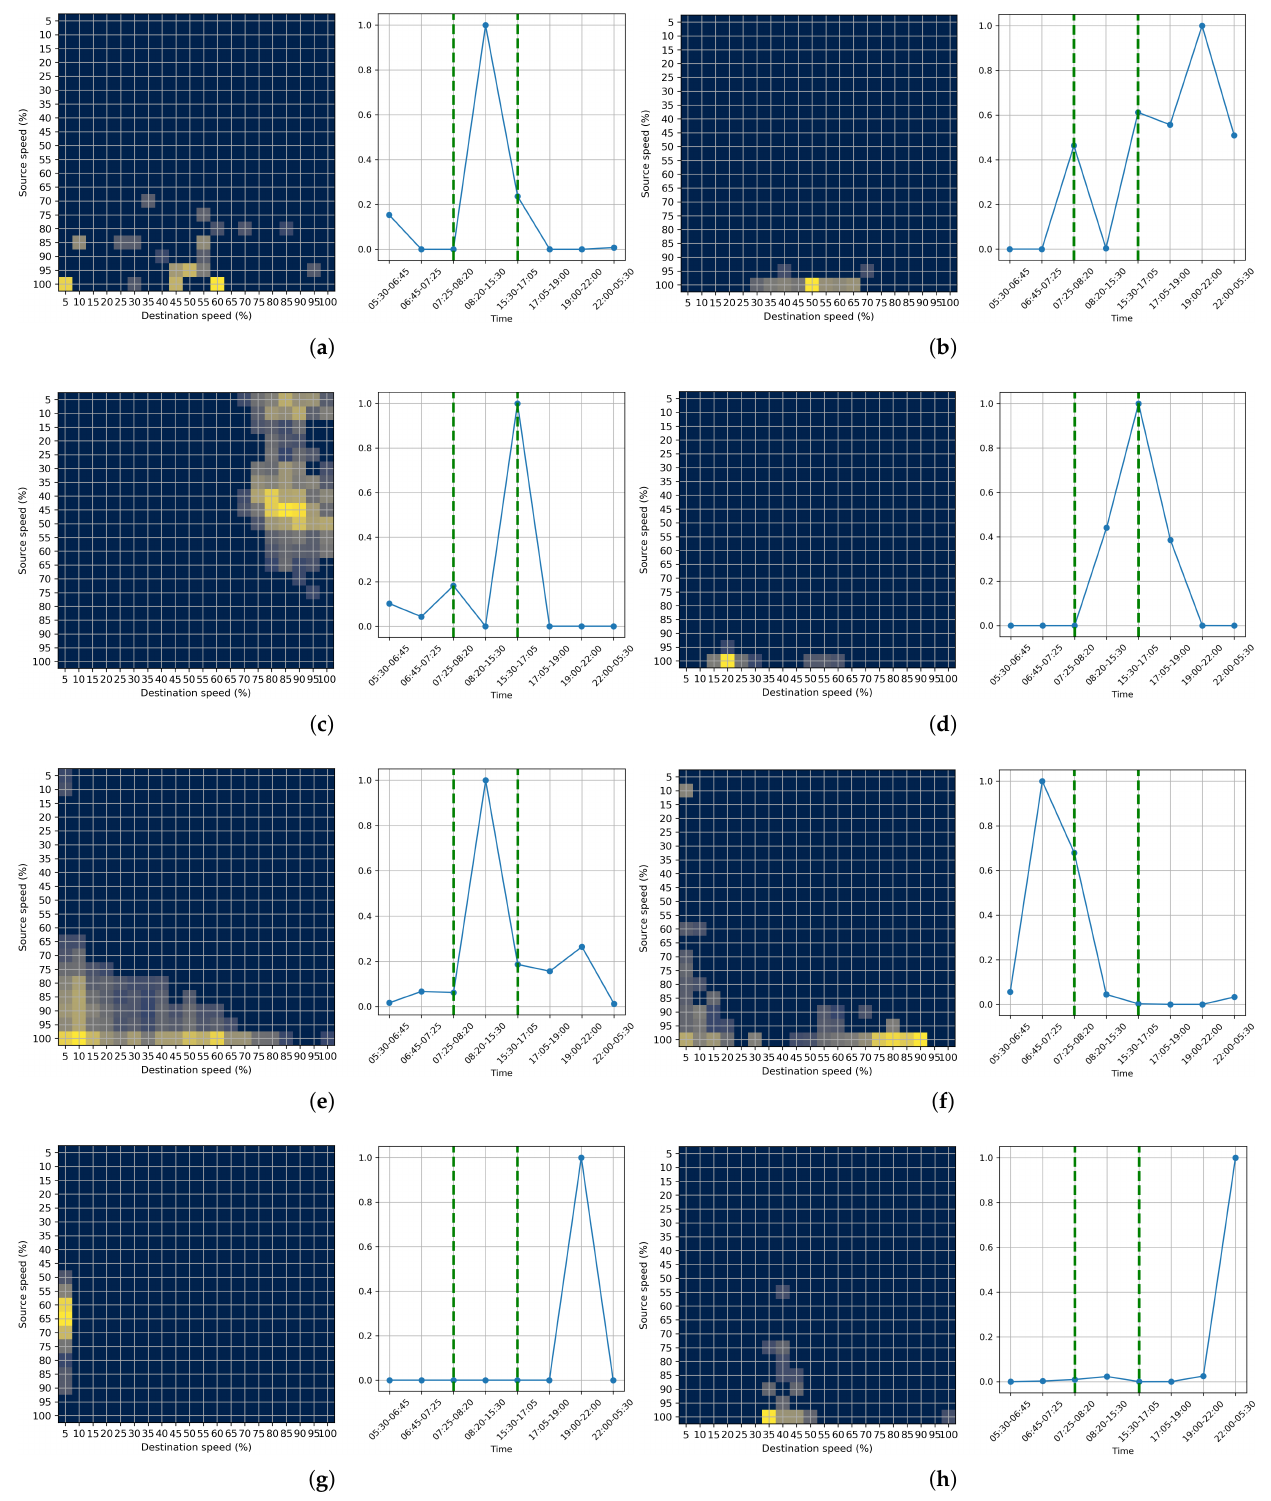
Figure 8. Results of the anomaly detection; ( a – h ) represent characteristic matrices which represent anomalous patterns ( left ) with corresponding temporal components ( right ). Figure 9 represents the spatial placement of the extracted abnormal cells, where every anomaly event is labeled with a letter that corresponds to the labels in Figure 8. The spatial placement of the anomalies indicates two spatial clusters: (i) Edges of the city